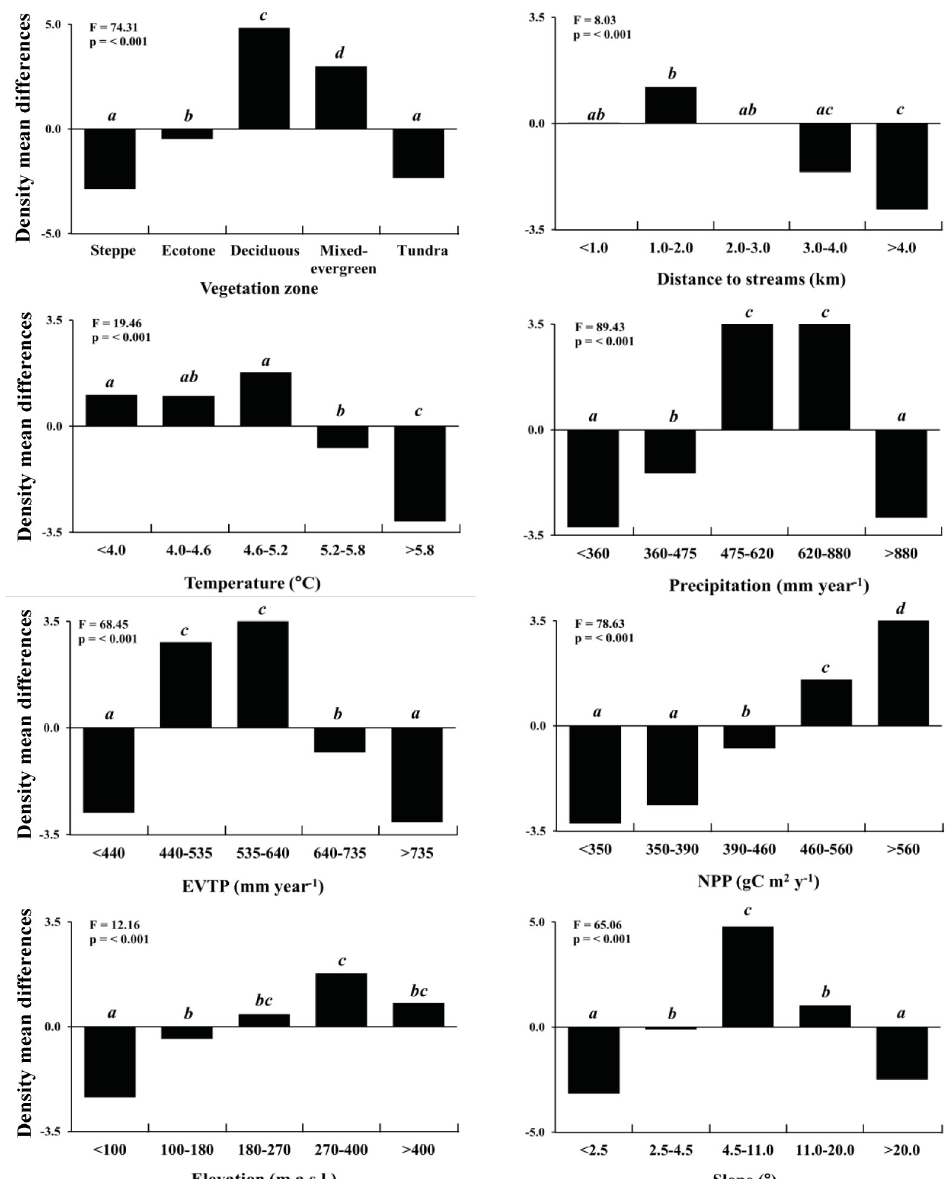
Fig 6. ANOVAs for the mean density differences (dams per km 2 ) comparing the analyzed geographic, climatic and topographic factors. Different letters indicate significant differences between the levels (Tukey’s test at p < 0.05). NPP = net primary productivity, EVTP =